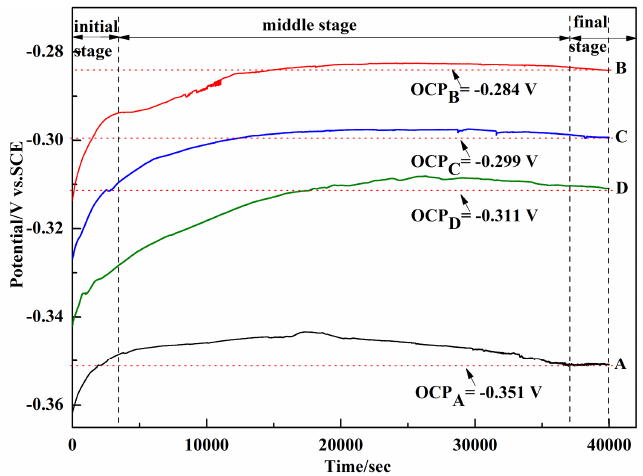
Figure 6. Open circuit potential evolution of the samples immersed in the four solutions as a function of exposure time.